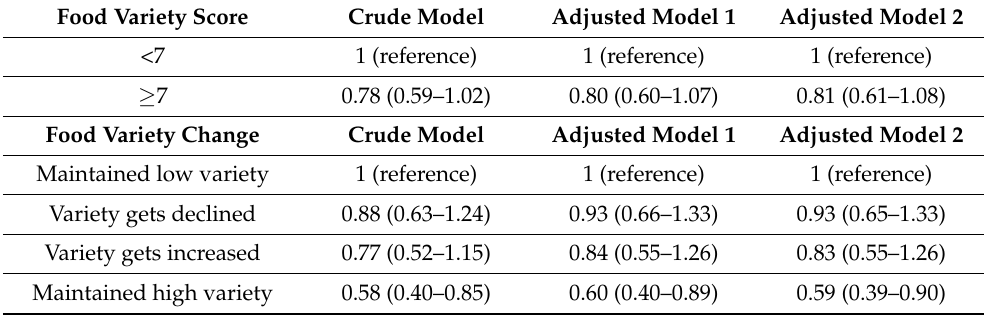
Table 2. Logistic regression analysis between food variety factors and the incidence of frailty.